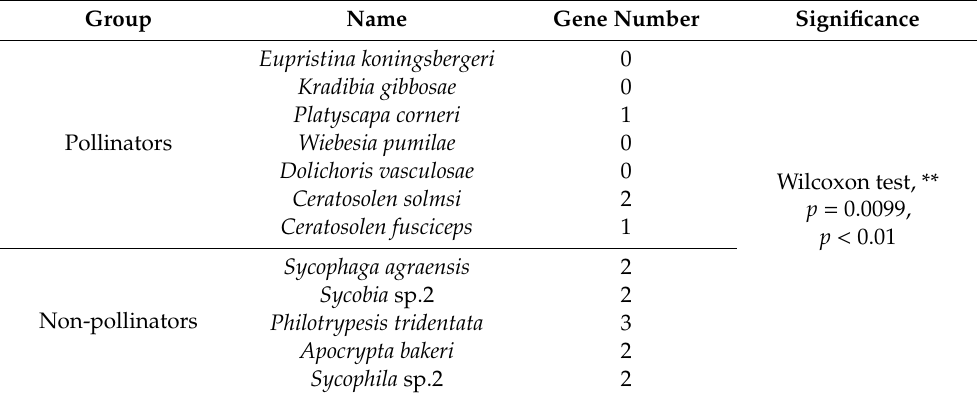
Table 2. The number of catalytic PGRP genes of pollinator and non-pollinator species.